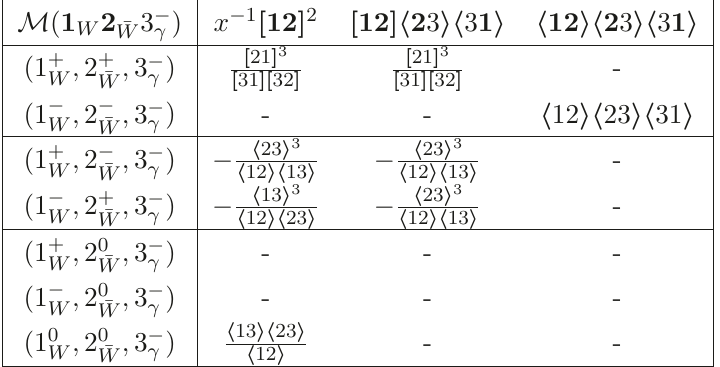
Table 6 . High-Energy limit of the three independent structures of the Entries denoted by ‘-’ appears only at order convenience, see eq. (4.10) for the full massive